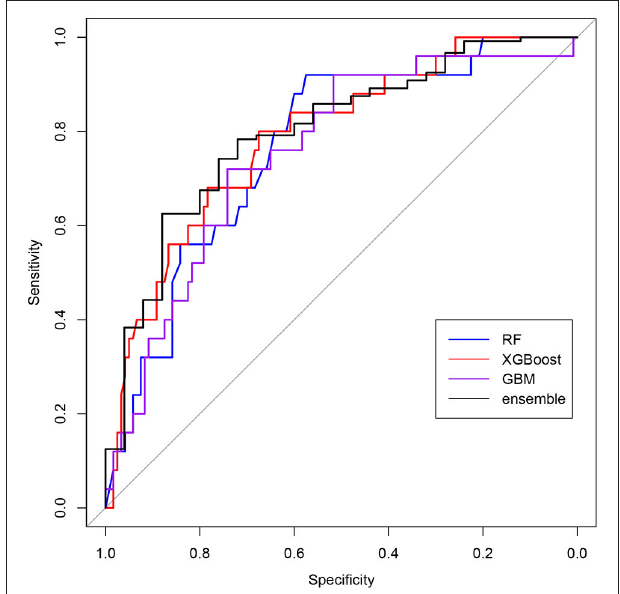
FIGURE 3 | ROC curves of the predictive models for the test set. Models assign a probability to every user and the sensitivity and specificity are calculated for all possible cut–off points. Blue corresponds to Random Forest (RF), red is Extreme Gradient Boosting (XGBoost), purple to Stochastic Gradient Boosting (GBM), and black to the ensemble of